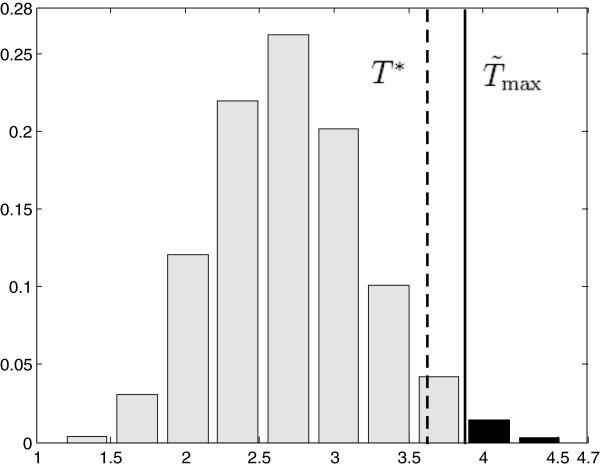
The histogram of Tmax,i obtained from the 1000 random permutations. The adjusted p-value (P = 0.02) is computed as the black area larger than the observed
T~max (solid line). The 95 percentile T∗ (dashed line) determines the region with significant dose difference as shown in Figure
6.